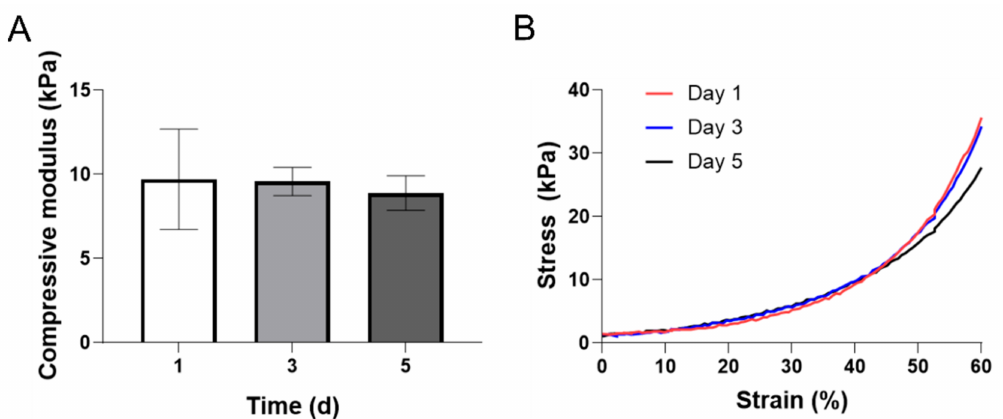
Figure 5. ( A ) Compressive modulus of Z-stacked GelMA sca ff old according to time courses: 1, 3, and 5 d. There were no statistically significant di ff erences. Data shown are the mean ± SD, n = 5. ( B ) A representative stress-strain curve of Z-stacked GelMA sca ff old according to time courses: 1, 3, and 5